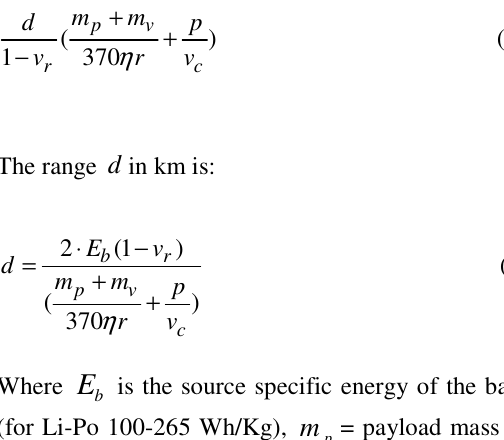
Figure 4: Range NAV vs Payload mass